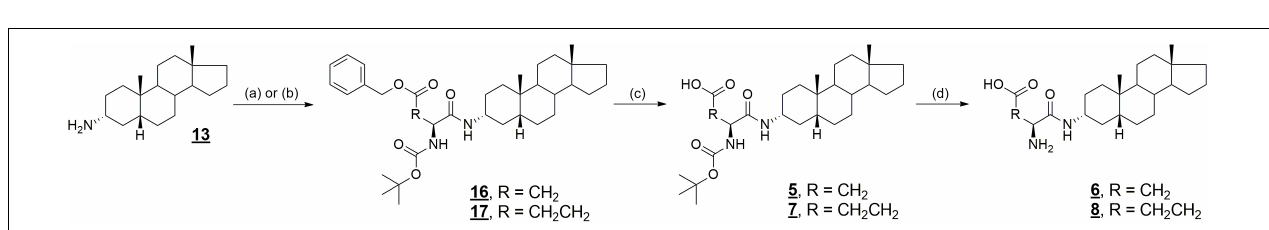
FIGURE 4 | Synthesis of compounds 5–8 and 16, 17. Reagents and conditions: (a) Boc-Asp(OBzl)-OH, DIPEA, DMAP, DCC, benzene, rt; (b) Boc-Glu(OBzl)-OH, DIPEA, DMAP, DCC, benzene, rt; (c) Pd/C, H 2 , MeOH, rt; (d) TFA, CH 2 Cl 2 , rt.